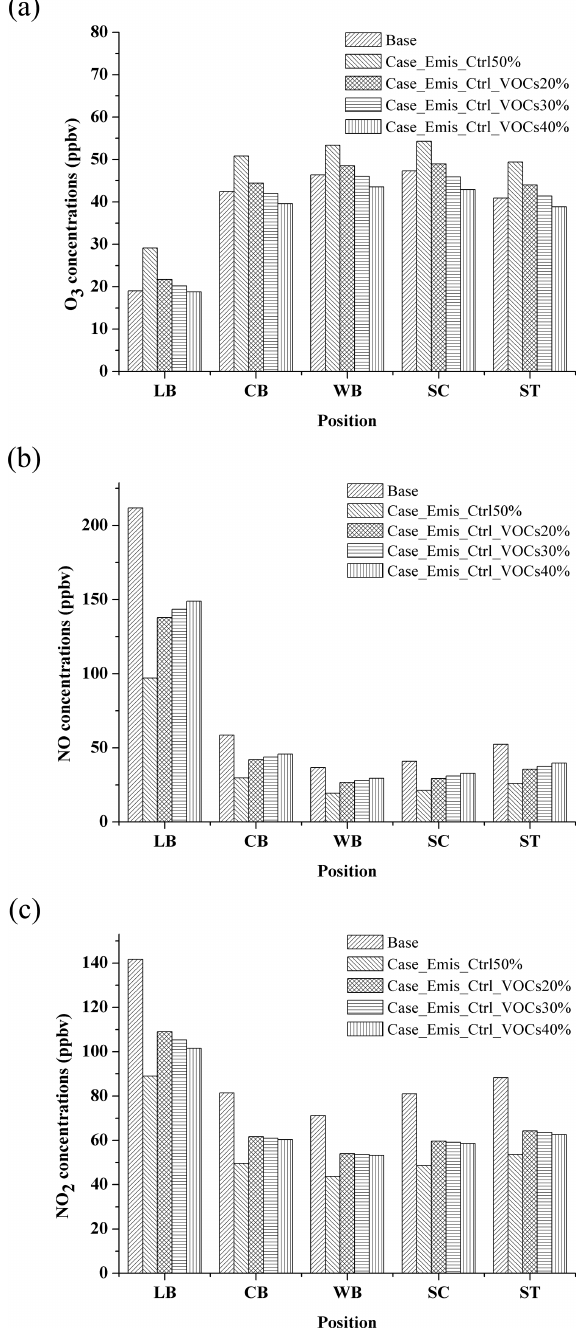
Figure 19. The (a) O 3 , (b) NO, and (c) NO 2 concentrations at 90min in different emission control